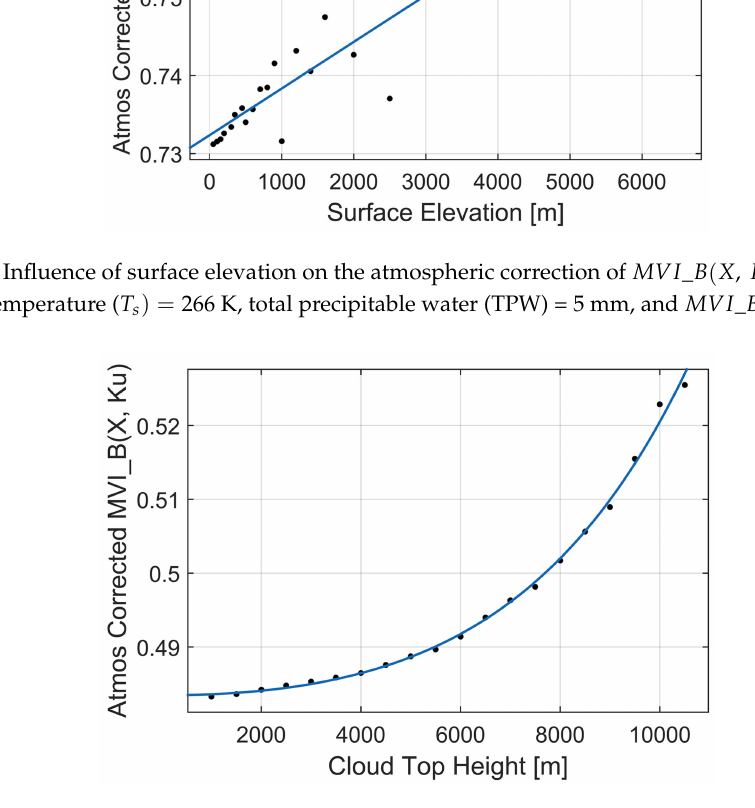
Figure 4. Influence of cloud top height on the atmospheric correction of MVI _ B ( X , Ku ) , when surface elevation = 17 m, T s = 300 K, total precipitable water (TPW) = 25 mm, cloud liquid water (CLW) = 0.1 mm, and MVI _ B ( f 1 , f 2 ) ∗ =